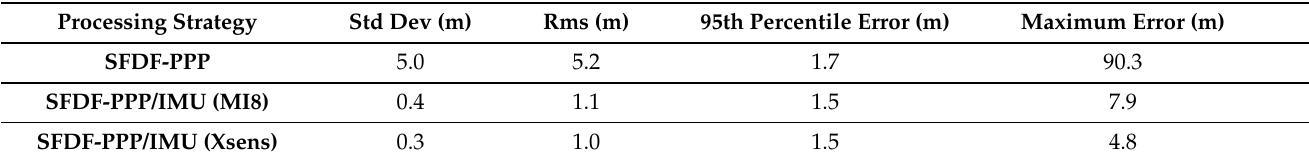
Table 7. Horizontal errors with different sensor fusion combinations for single- and dual-frequency PPP processing.